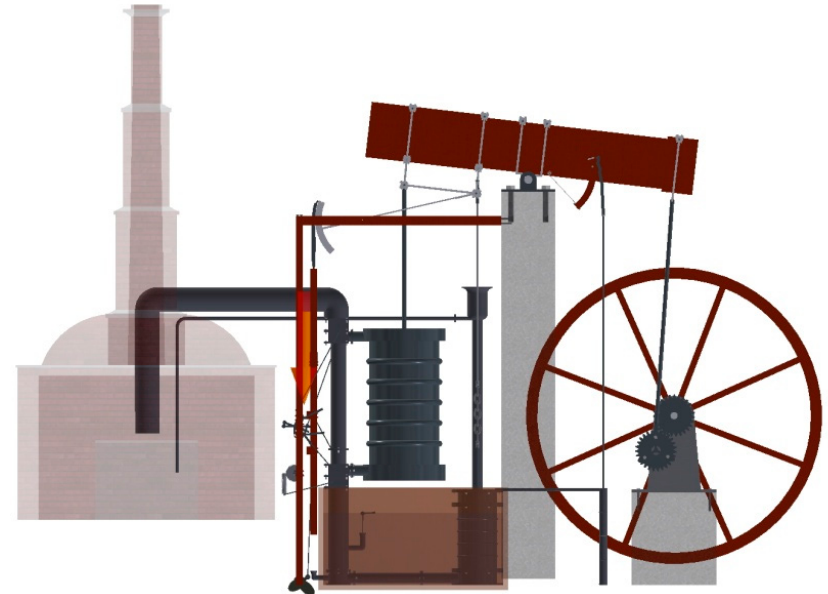
Figure 7. Gravitational force applied at the centre of gravity of the engine.